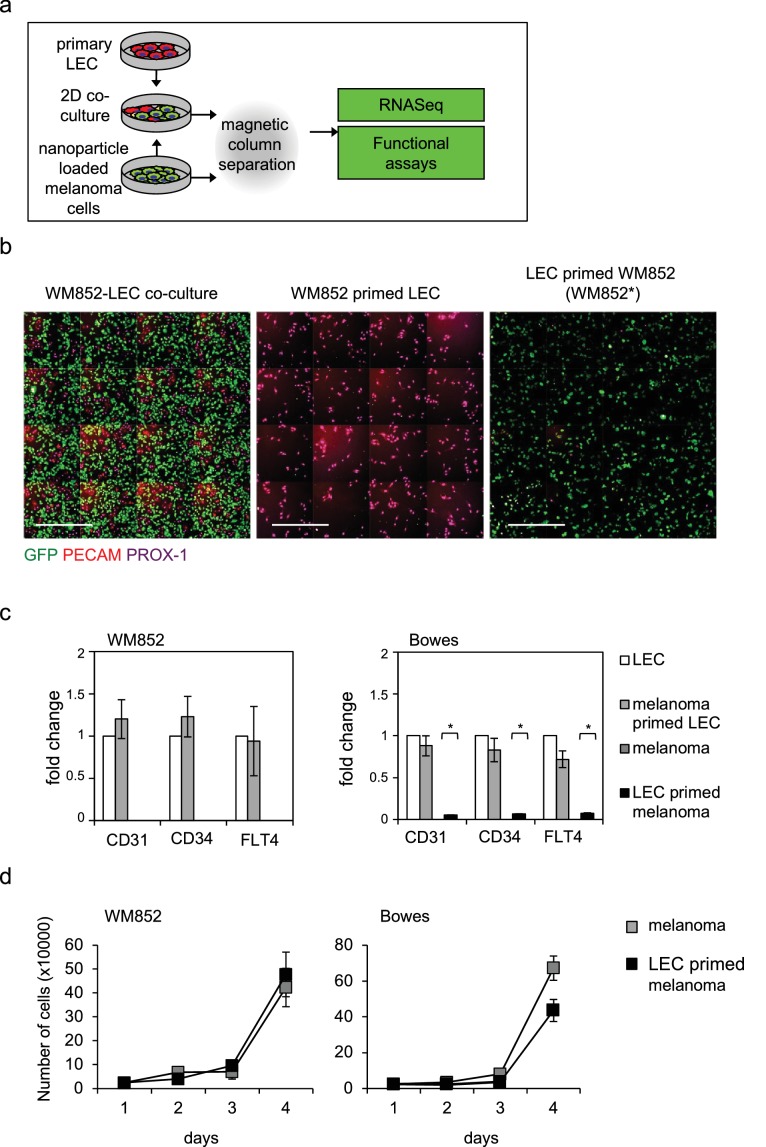
Optimization of magnetic separation of melanoma and LEC cells following co-culture of LEC and melanoma cells.(a) Schematic of the workflow for cell separation from the melanoma-LEC 2D co-cultures. (b) WM852-LEC co-culture (left), flow through of the magnetic column (middle) and the separated elute (right) were stained for GFP (green), PECAM (red), and PROX-1 (magenta) and visualized by indirect immunofluorescence using high-content imaging. Panels of 16 (4 × 4) images are shown. (c) Relative mRNA fold changes of the indicated targets in LECs and melanoma cells derived from monotypic cultures or co-cultures (*) followed by magnetic separation. Average of three independent experiments, error bars indicate SEM. *: p<0.05. (d) Cell count at different time points following magnetic separation of WM852 (left) and Bowes (right) from monotypic culture or after LEC priming in the co-culture. Graphs show an average of two independent experiments, error bars indicate SD.